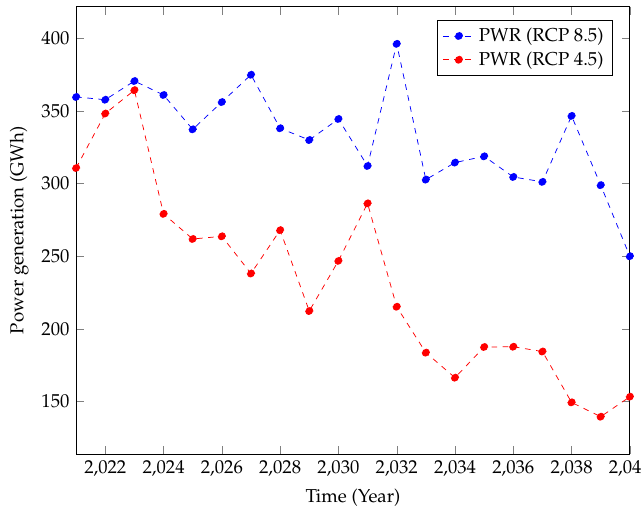
is shown in Table 2.